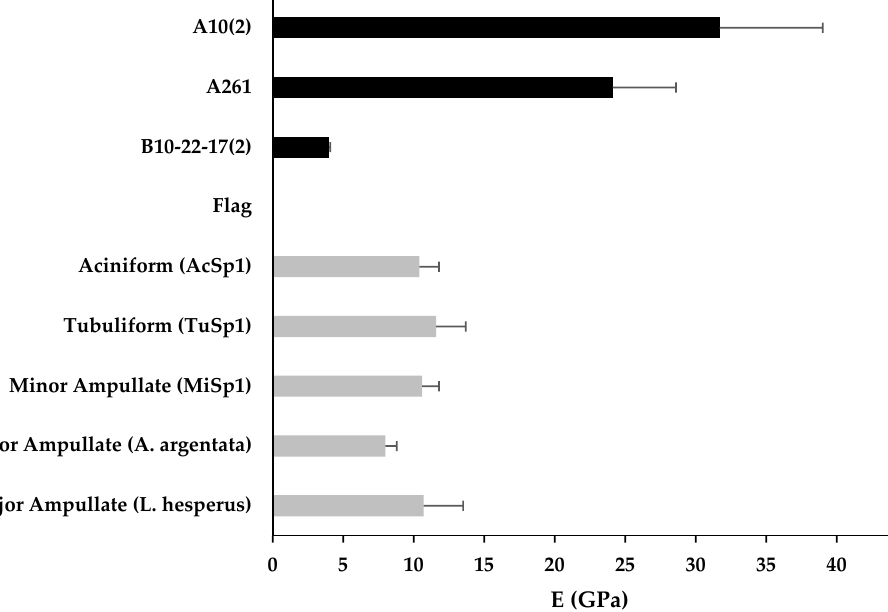
Figure 5. Summary graph showing Young’s modulus for uninduced Library A samples and methanol induced library B samples along with Young’s modulus for selected native proteins. Young’s moduli for native proteins derived from Instron tensile testing measurements of full-length fibers from [35]. Mean and standard deviation shown.